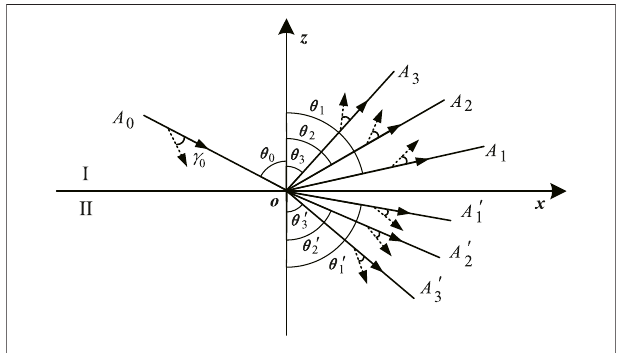
FIGURE 1 | Re fl ection and transmission of plane waves at the interface separating two thermoelastic media. The solid and dashed arrows represent the propagation and attenuation directions, respectively.